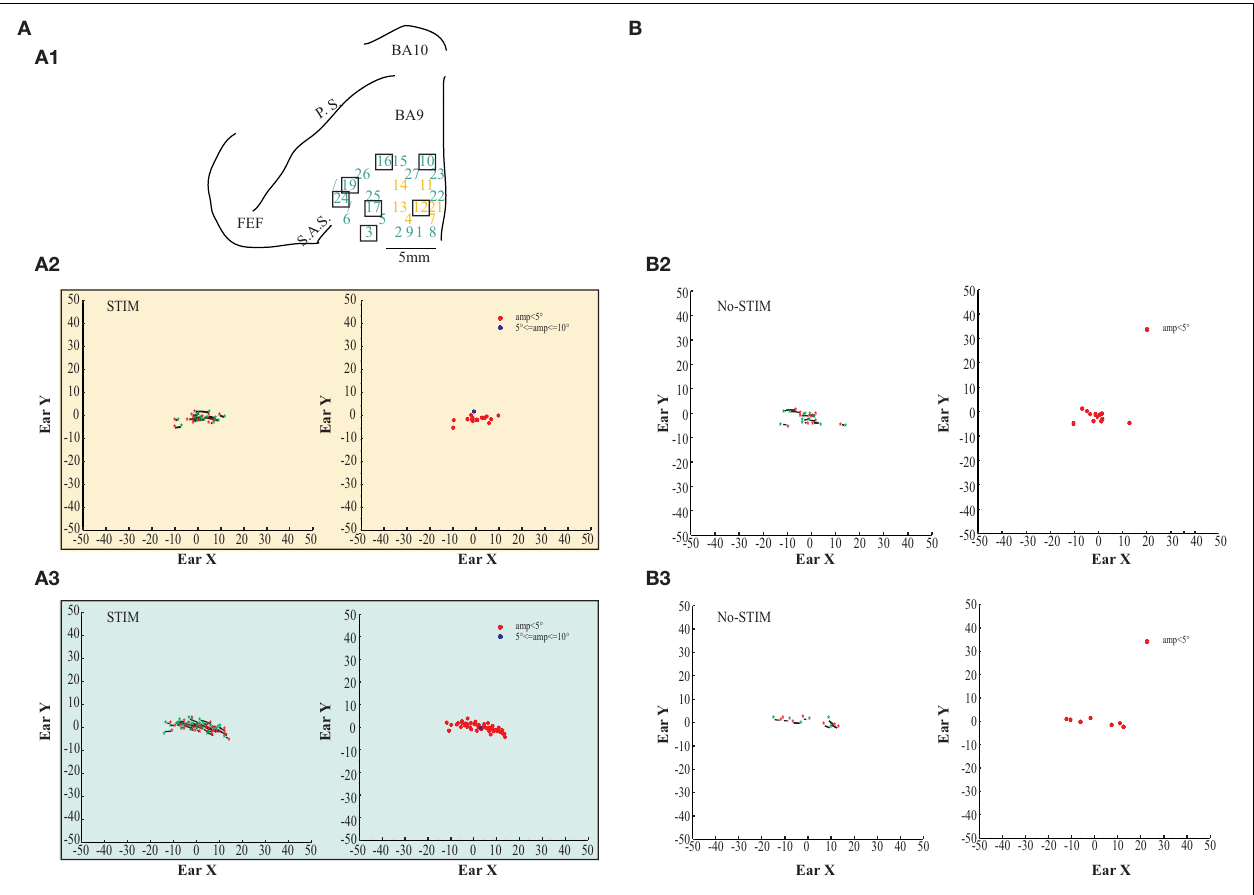
FIGURE 5 | Example of fixed-vector ear movements. (A) The figures show data from Monkey S. For further information on the figures the reader should refer to the legend of Figure 3 .